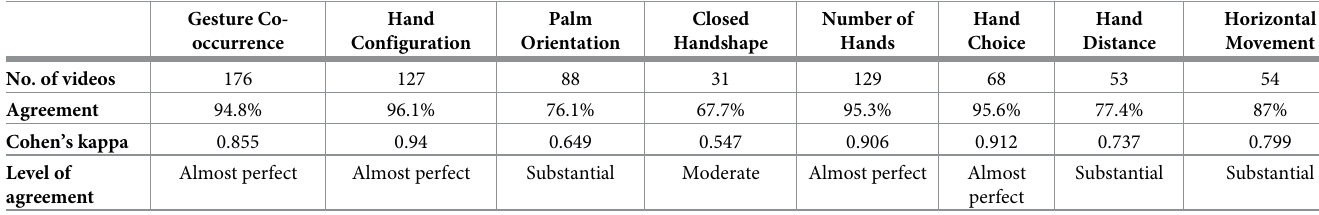
Table 2. Inter-rater reliability between Coder 1 and Coder 2 of coding decisions relating to our hypotheses. Gesture Co-